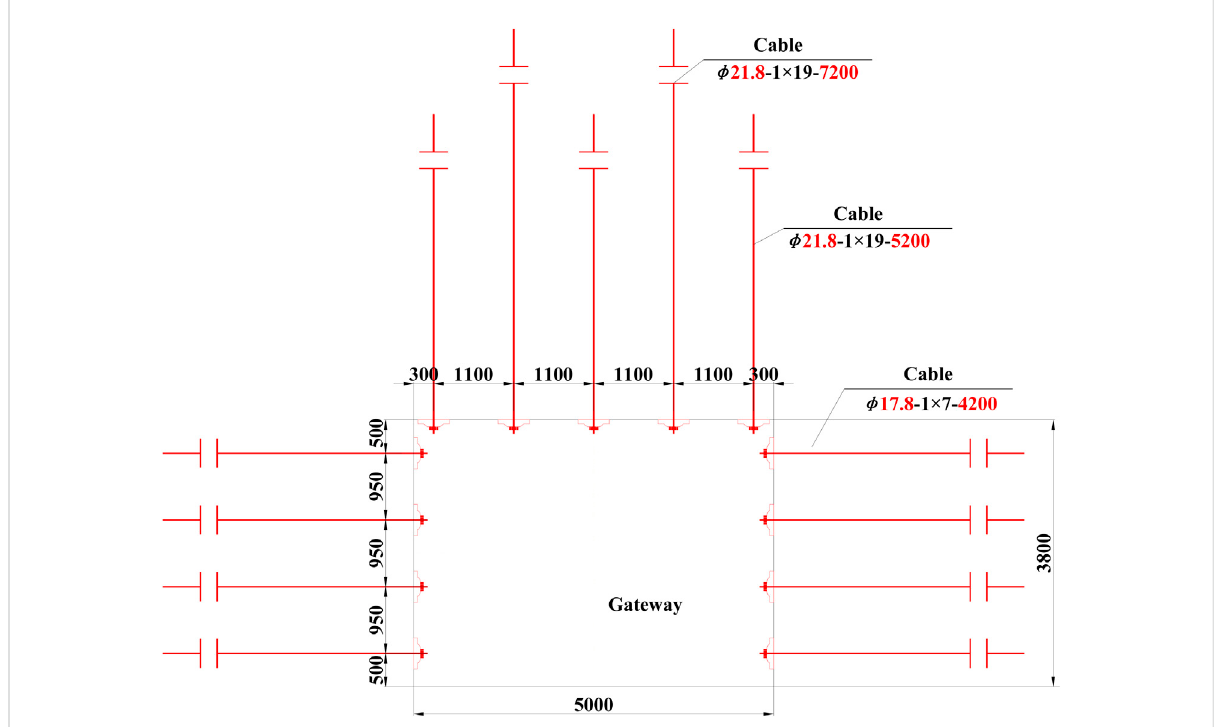
FIGURE 10 Schematic diagram of high prestressed full cable strong support technology (unit: